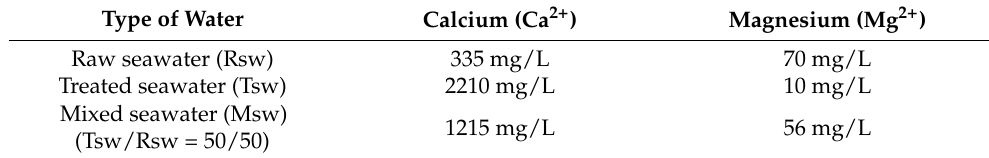
Table 3. Divalent cation concentration at pH 11.